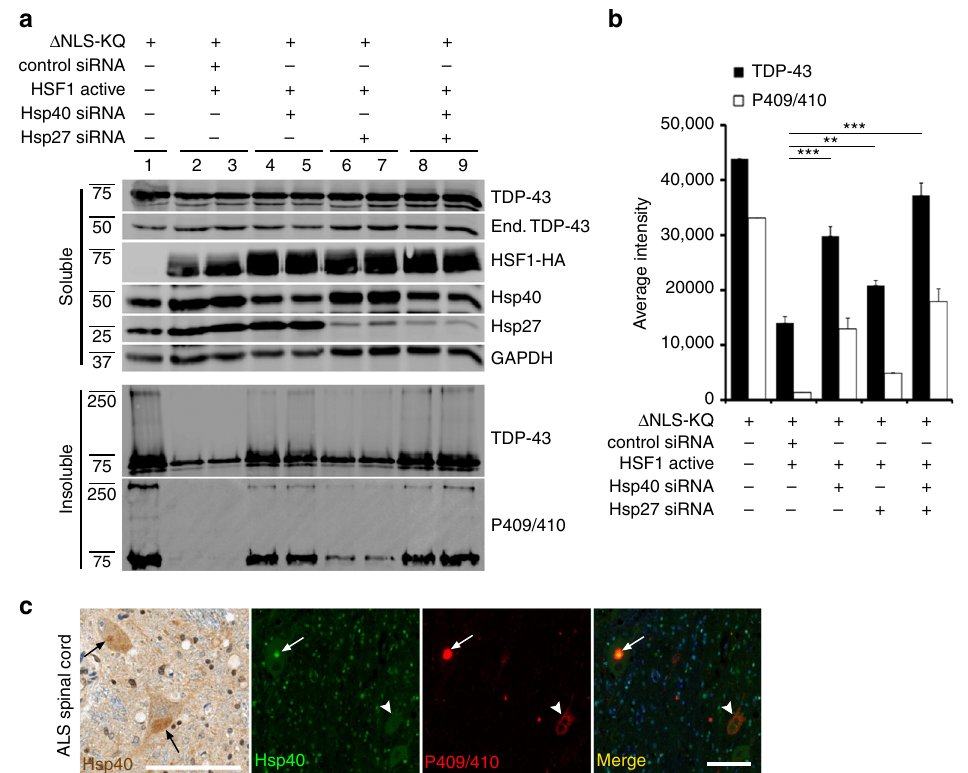
Fig. 9 Depletion of Hsp27 and Hsp40 impairs HSF1-mediated disaggregation of acetylation-mimic TDP-43. a Cells co-transfected with TDP-43- Δ NLS- K145Q ( Δ NLS-KQ) and active HSF1 were treated with control siRNAs or speci fi c siRNAs targeting either Hsp40 or Hsp27 and subsequently analyzed by immunoblotting using TDP-43, P409/410, HSF1, Hsp40, Hsp27, and GAPDH antibodies. b The average aggregate intensity was quanti fi ed to assess the insoluble TDP-43 levels that were restored by Hsp27 or Hsp40 siRNA treatments. Error bars indicate SEM, and the asterisk indicates statistical signi fi cance with *** p -value < 0.001 and ** p -value < 0.01, as measured by Student ’ s t -test from N = 3 biological replicates. ns = not signi fi cant. c Lumbar ALS spinal cord was analyzed by immunohistochemistry using an Hsp40 antibody or double-labeled using Hsp40 and phosphorylated TDP-43 (P409/410) antibodies. Nuclei were stained with DAPI. The black arrows indicate focal, cytoplasmic, round Hsp40 accumulation. The white arrows highlight co-localization of Hsp40 with phosphorylated TDP-43 aggregates, while the white arrowhead indicates a skein-like amorphous TDP-43 inclusion that is devoid of Hsp40. Scale bar = 100 μ